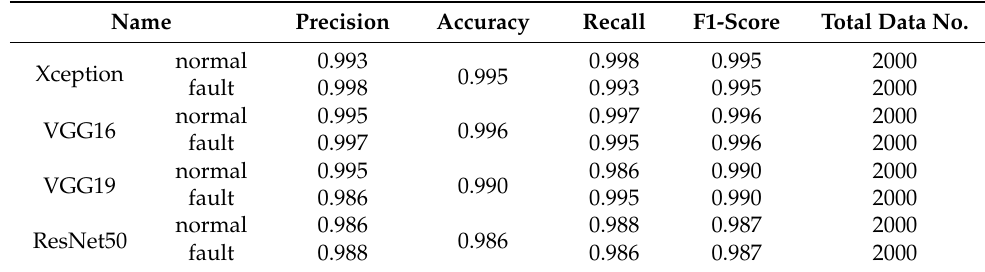
Table 3. Test dataset classification results.